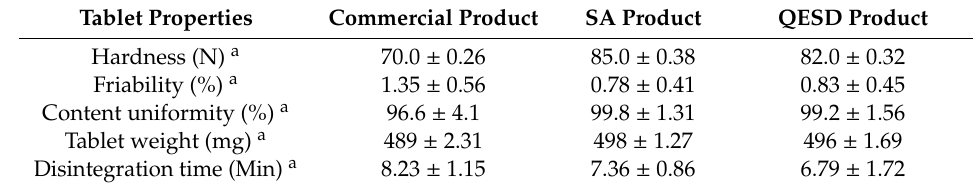
Table 4. Hardness, friability, disintegration time, tablet weight and content uniformity of azithromycin